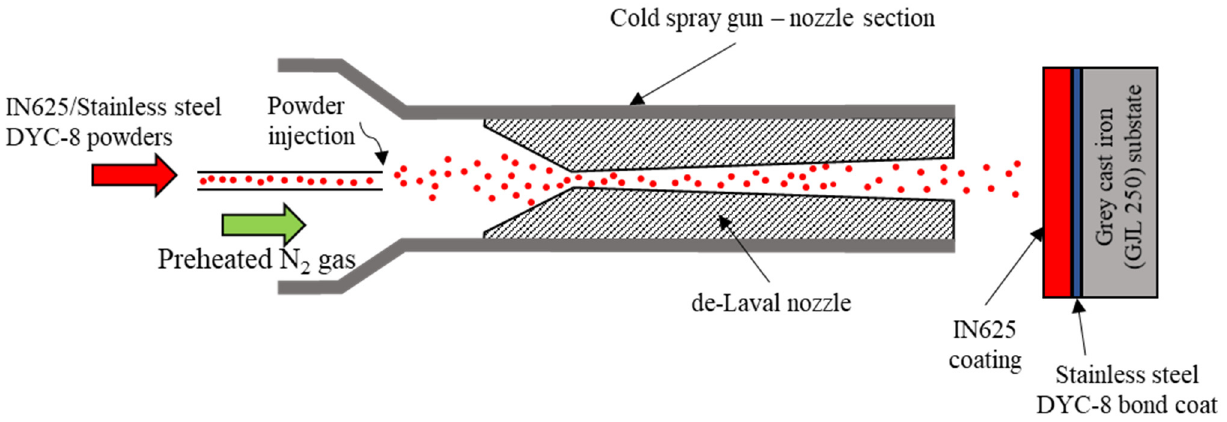
Figure 1. Schematic of the cold spray deposition.